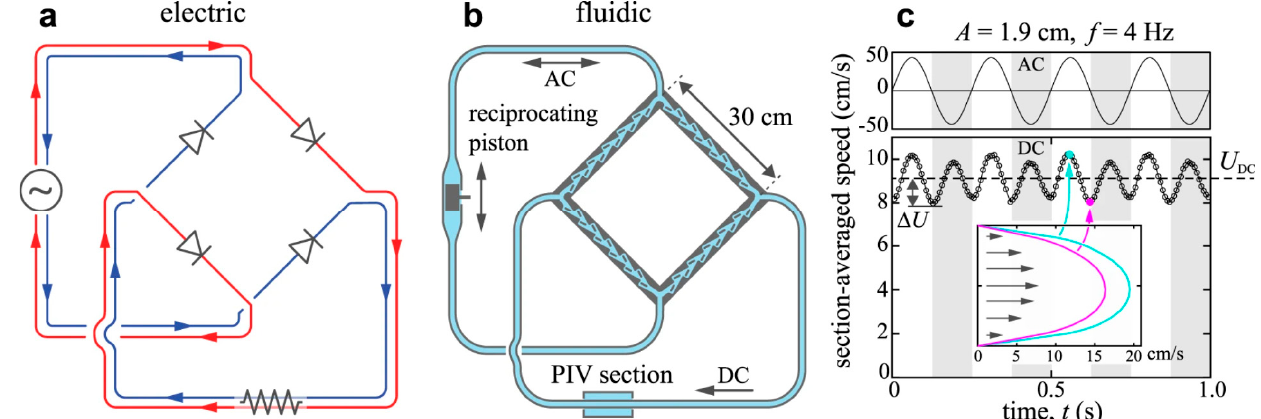
Figure 3. The equivalent circuit of electrical ( a ) and fluidic ( b ) rectifier using four TV channels. ( c ) The performance of fluidic rectifiers with comparable parameters in the electrical variables.